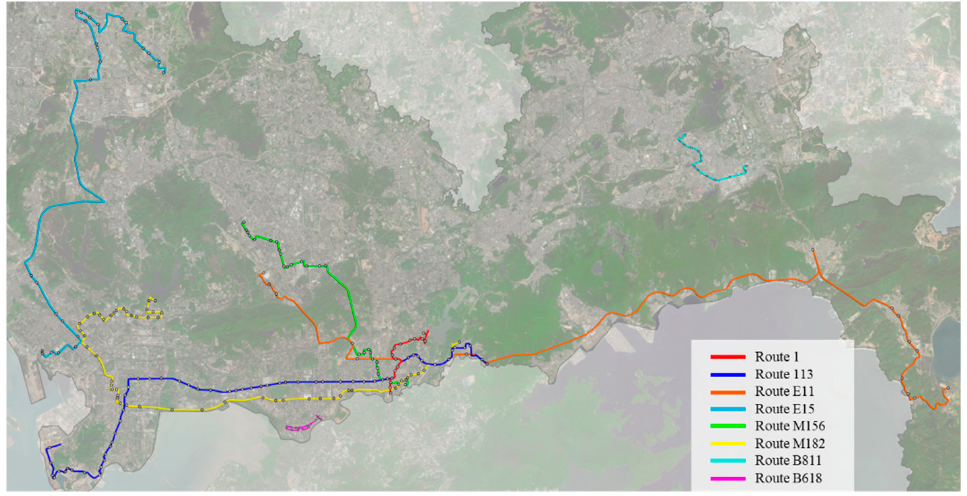
Figure 3. Map of selected bus routes. Table 1. Basic information about selected bus routes. Route